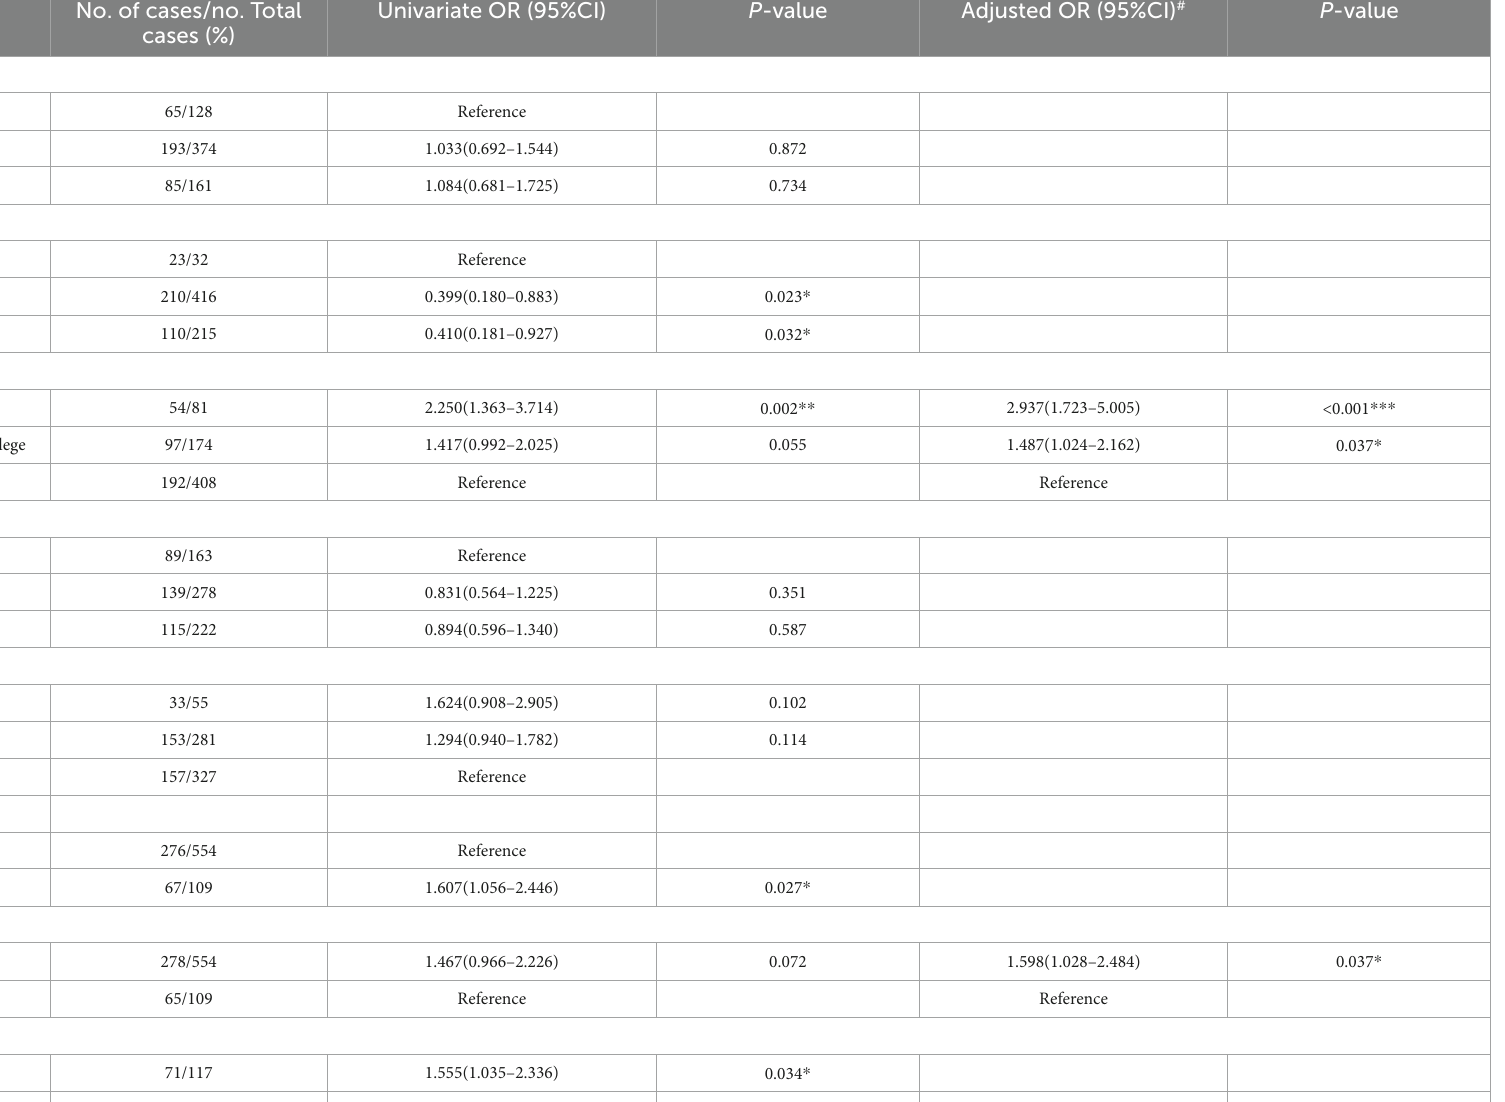
TABLE 7 Risk factors for trait anxiety (T-AI scores) identified by multivariable logistic regression analysis ( n = 663).